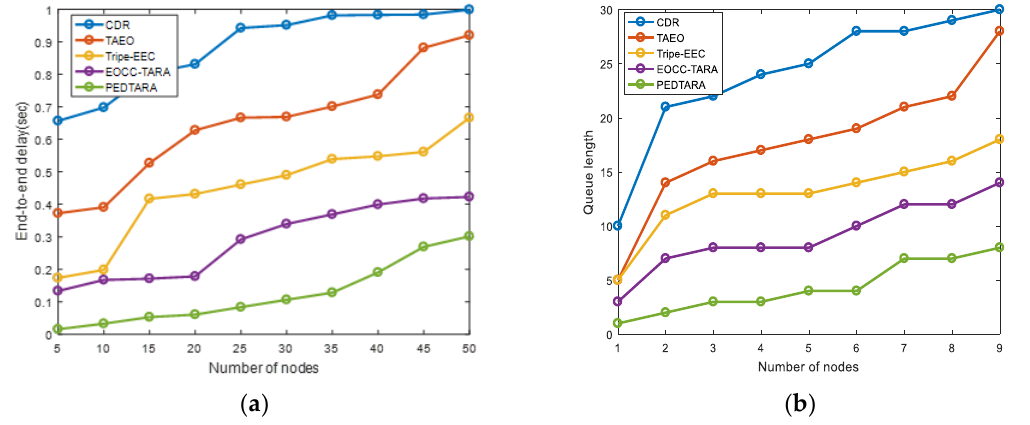
Figure 6. End-to-end delay and queue length comparisons: ( a ) end-to-end delay; ( b ) queue length. Table 3. End-to-end delay (seconds). Table 4. Queue length.